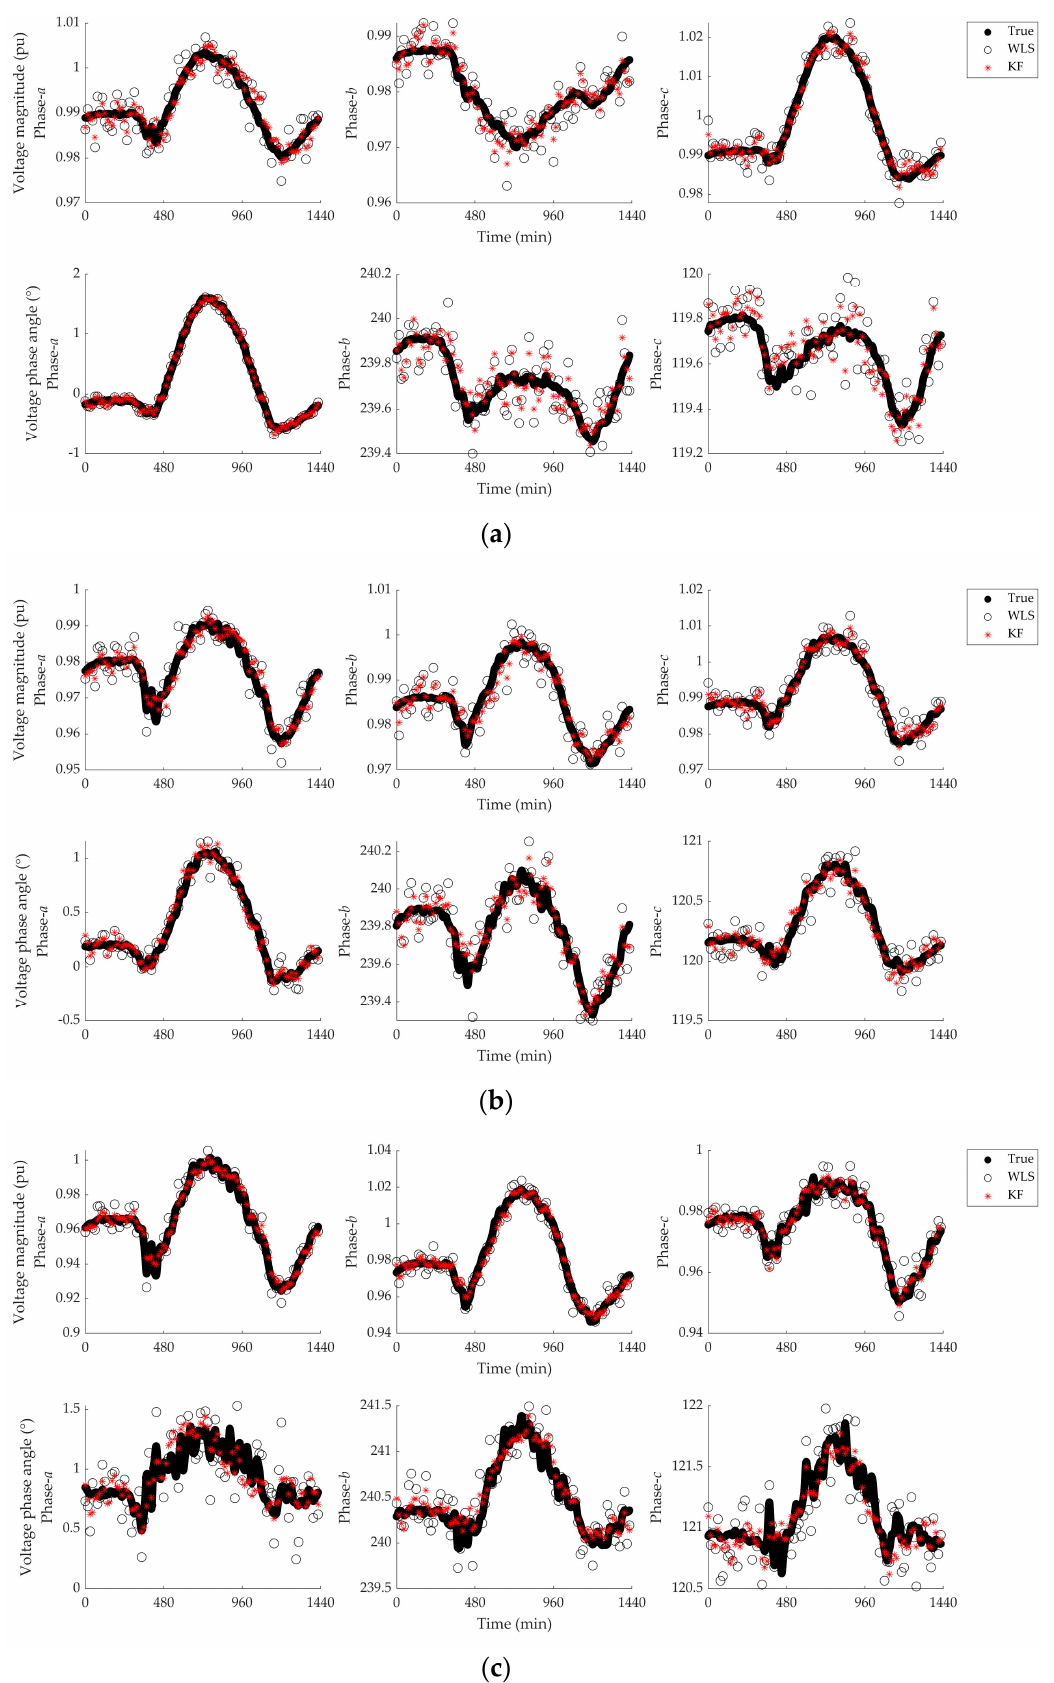
Figure 6. Estimated state values at buses ( a ) 47, ( b ) 63, and ( c ) 122.